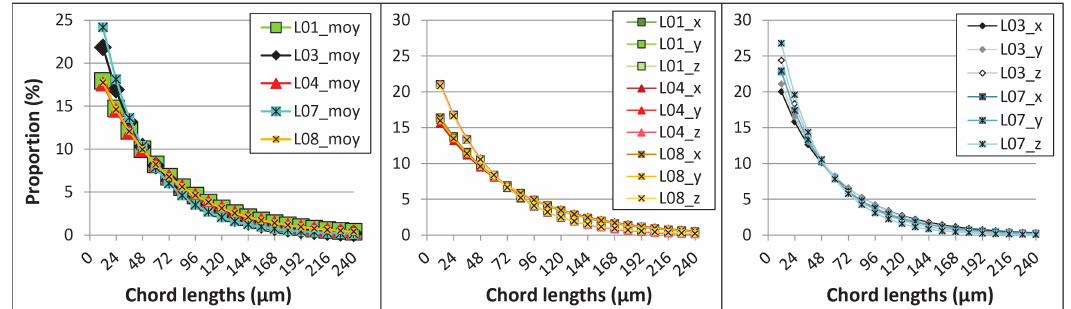
Figure 8. Chords length distribution for Lexos samples, pore diameters are displayed by proportion. On the left, an average of chord lenghts in the three directions is shown. On the middle and right, chord lengths are detailed in directions X, Y and Z: L01, L04 and L08 on the middle, and L03 and L07 on the